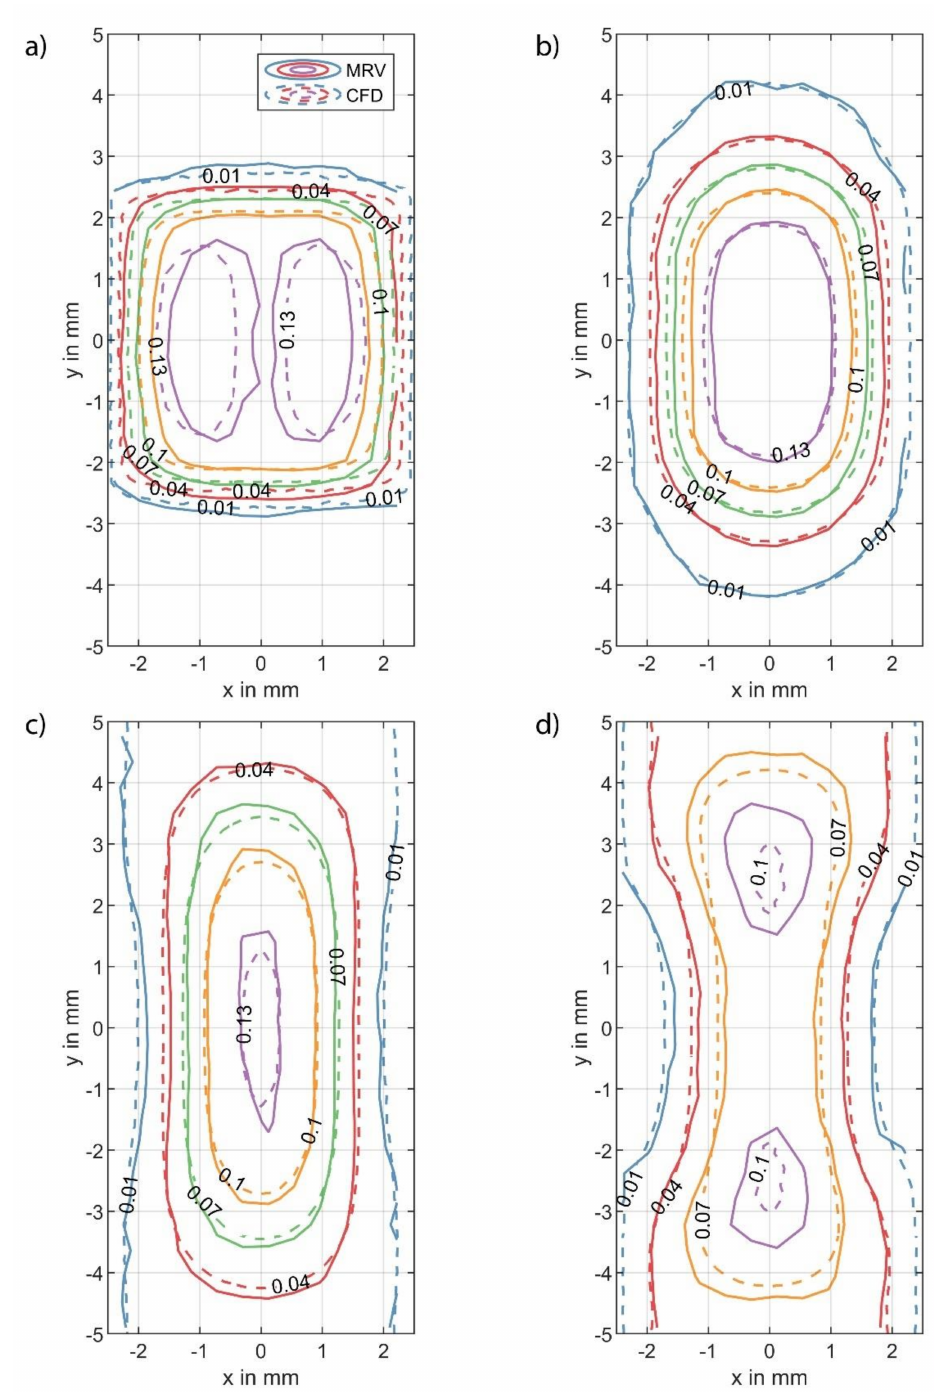
Figure 6. Comparison of the MRV (solid lines) and CFD (dashed lines) axial velocity component ( u z ) contours along planes in the fourth layer of the pore structure as depicted in Figure 4 at the following distance from the inlet of layer four: 0.02 mm ( a ), 1.46 mm ( b ), 2.72 mm ( c ), and 3.56 mm ( d